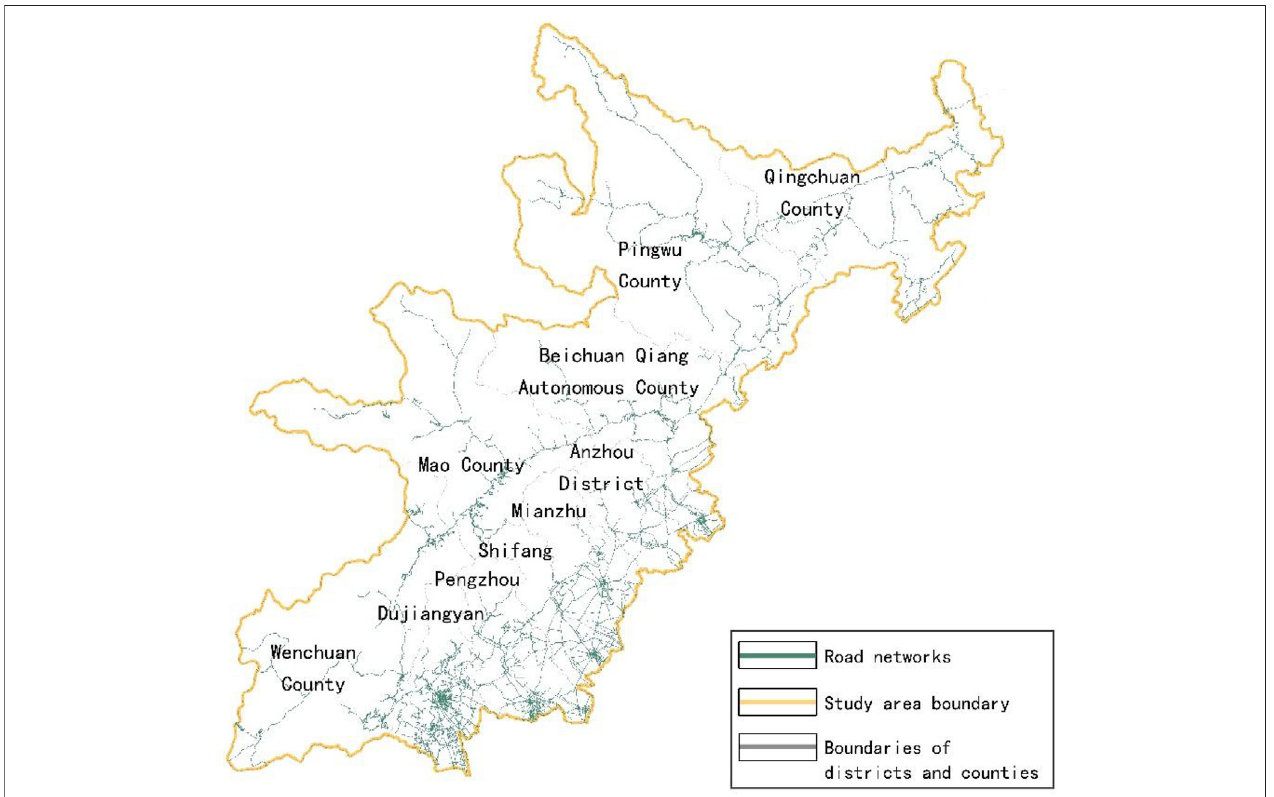
FIGURE 4 | Pre-earthquake road